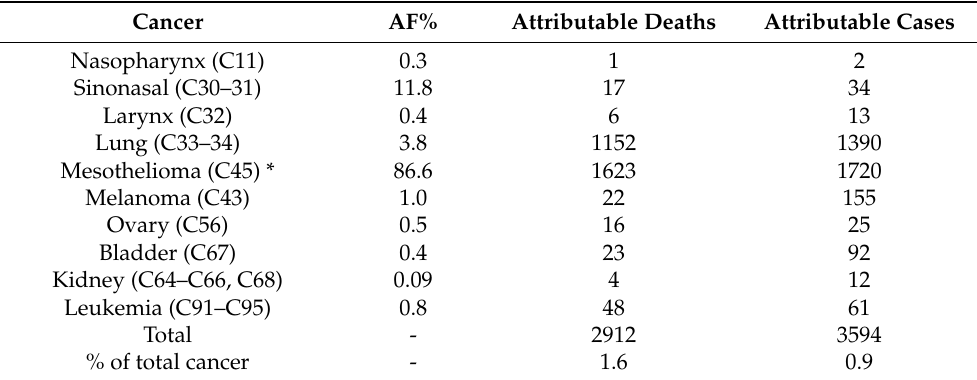
Table 2. Attributable fraction (AF), and number of deaths in 2017 and cases in 2020 attributable to occupational carcinogens in Italy by cancer